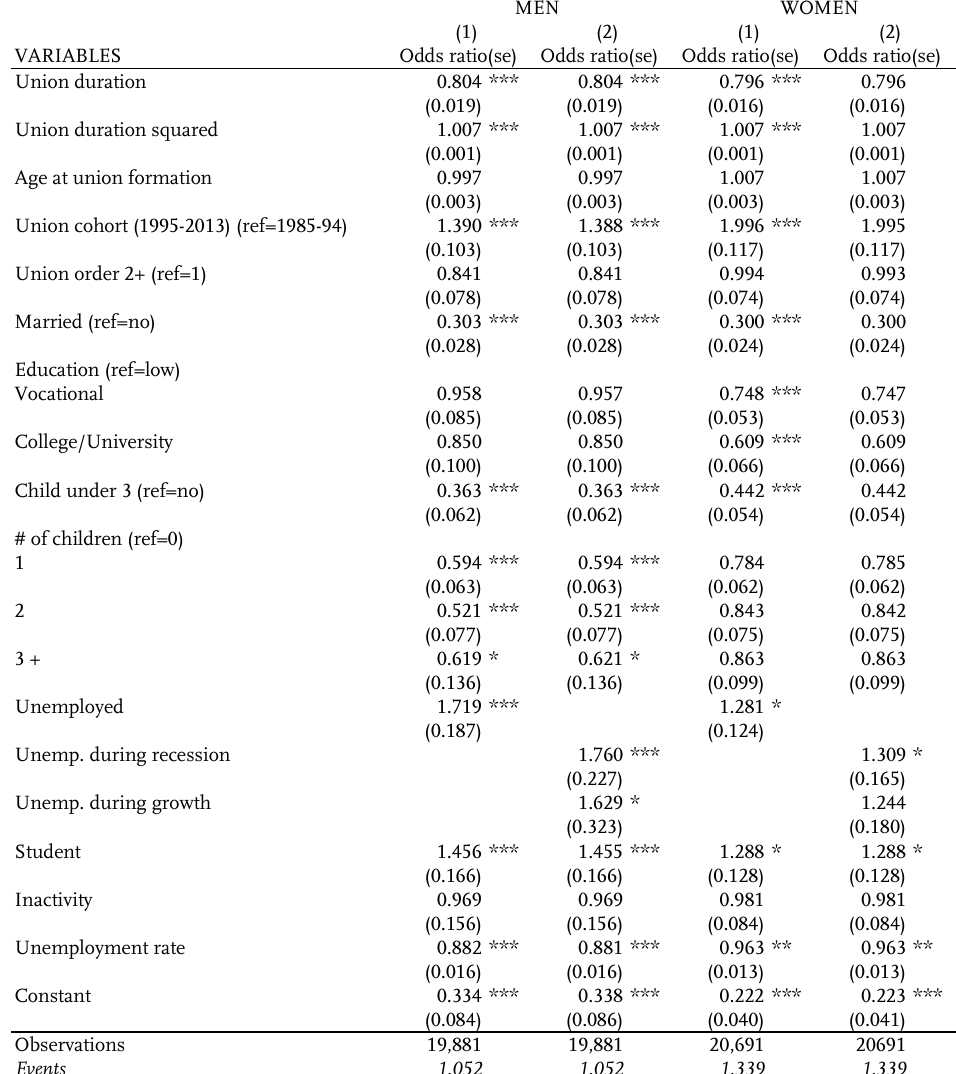
Table A.4 : Discrete time model, full results by country: Germany MEN WOMEN (1) (2) (1) (2) VARIABLES Odds ratio(se) Odds ratio(se) Odds ratio(se) Odds ratio(se) Union duration 0.804